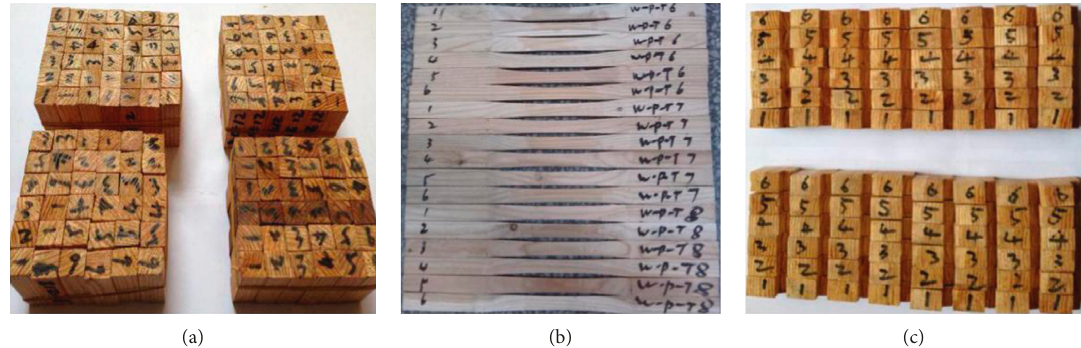
Figure 5: Specimens for three tests: (a) compressive specimens; (b) tensile specimens; (c) shear specimens.